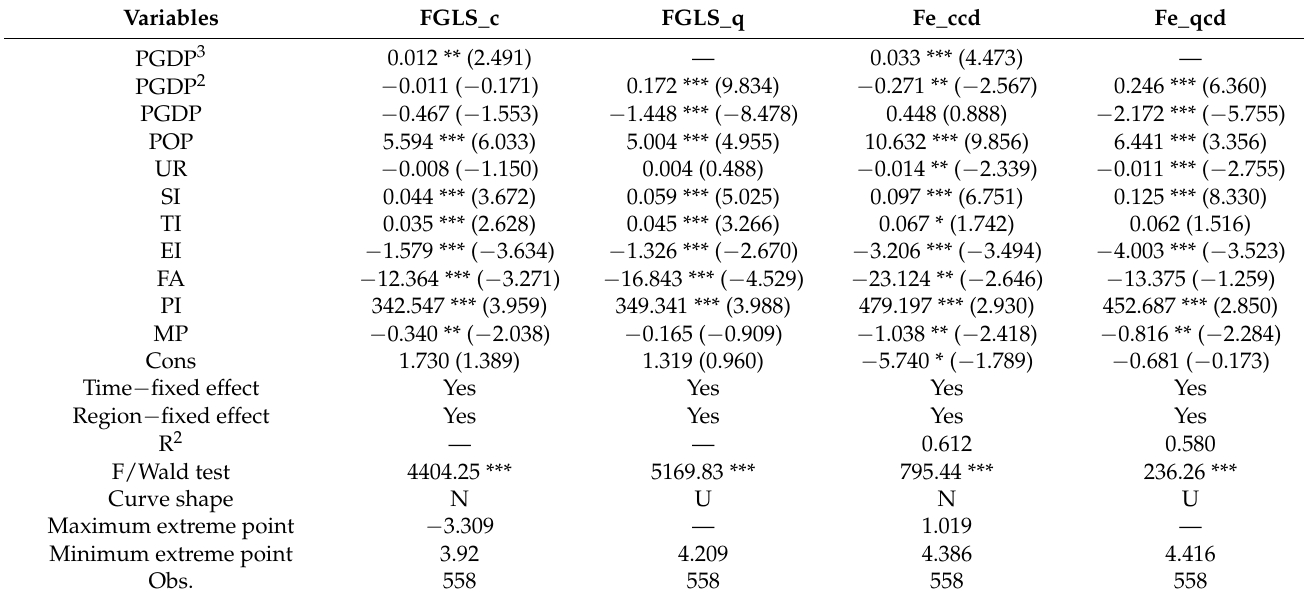
Table 8. Estimation results after changing the estimation